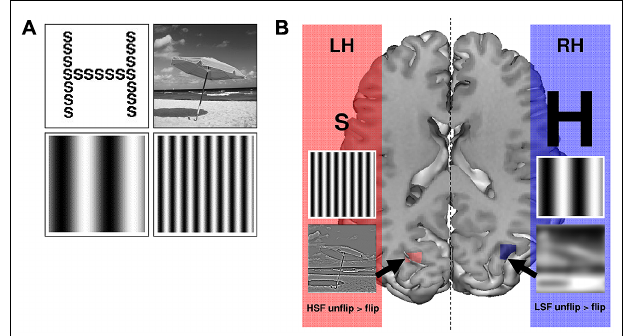
FIGURE 2 | (A) Example of stimuli used to assess cerebral asymmetries for spatial frequencies.Top-left: Hierarchical visual forms, consisting of a large global letter made up of small local letters;Top-right: Scene; Bottom-left: low spatial frequency (LSF) sinusoidal grating; Bottom-right: high spatial frequency (HSF) sinusoidal grating. (B) Hemispheric specialization: the left hemisphere (LH) is predominantly involved in the local letter identification, HSF grating identification and HSF categorization; the right hemisphere (RH) is predominantly involved in the global letter identification, LSF grating identification and LSF categorization. Activations reported showed stronger activation in the left than the right occipital cortex for HSF categorization [(HSF unflip > flip) contrast] and stronger activation in the right than the left occipital cortex for LSF categorization [(LSF unflip > flip) contrast]. Figure adapted from Peyrin etal.